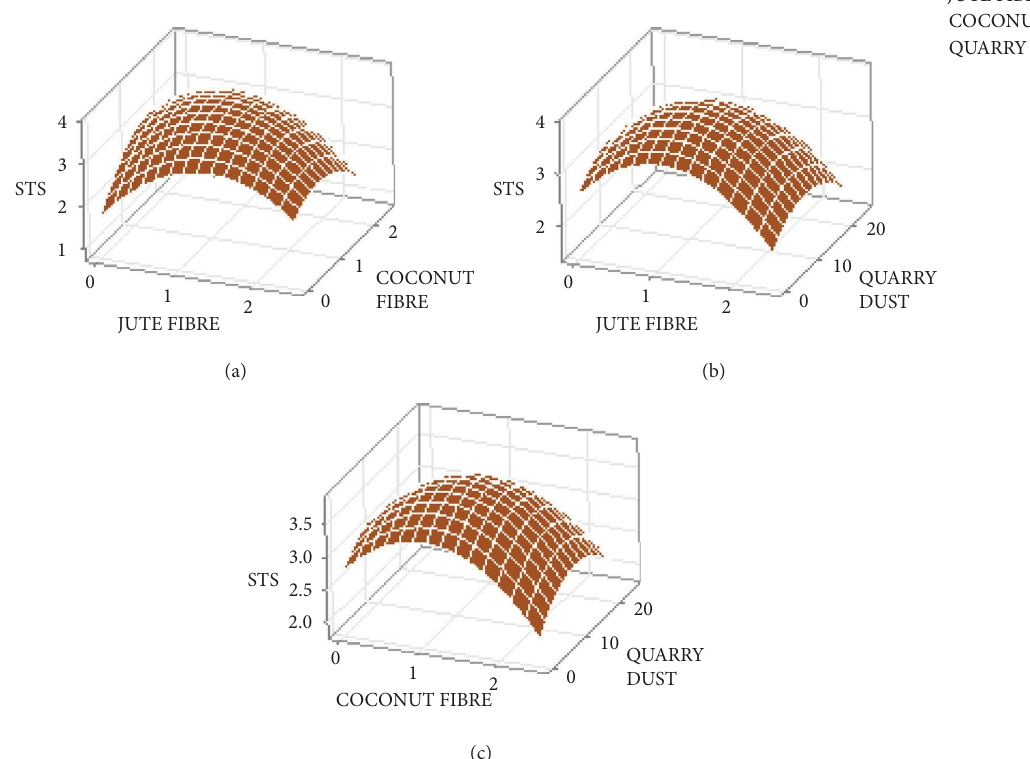
Figure 8: Surface plots for split tensile strength as a function of (a) jute fbre and coconut fbre; (b) jute fbre and quarry dust; (c) coconut fbre and quarry